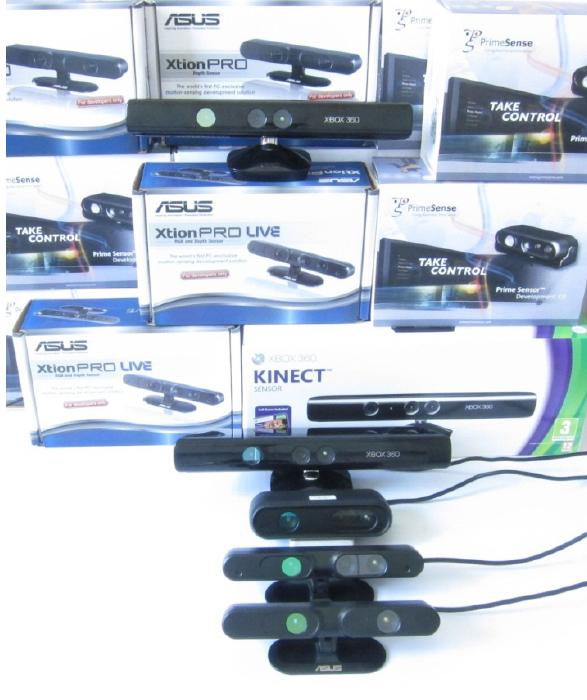
Figure 2. Graphical comparison of one sensor at a larger stand- off distance (top) or two sensors on top of each other at a shorter stand-off distance (bottom).